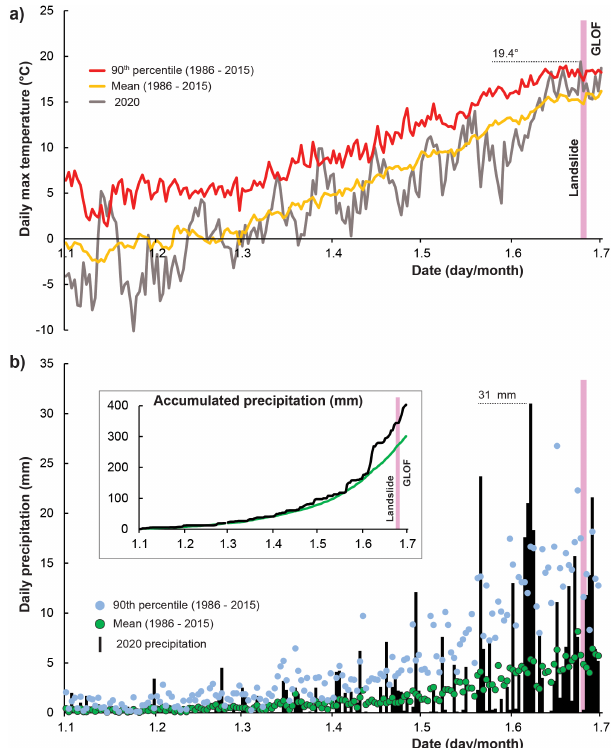
Figure 7. Meteorological conditions from January–June 2020, mea- sured at the Lhari weather station, compared to the longer-term cli- matology